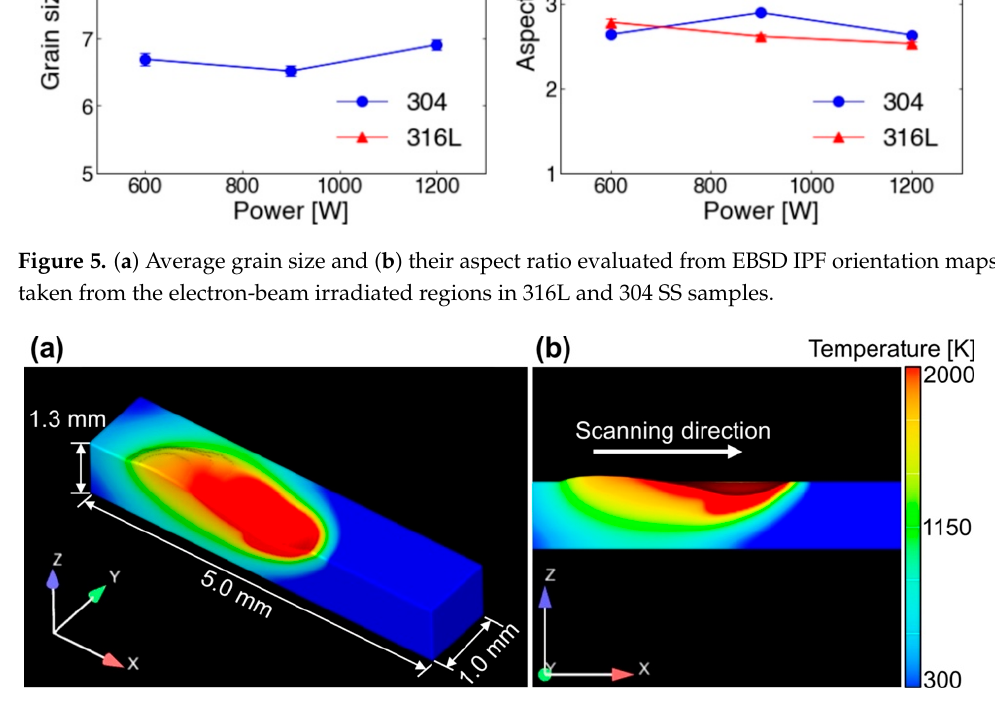
Figure 6. Snapshot of CtFD simulation of electron-beam irradiation on 316L SS with process parame- ters of P = 1200 W and V = 100 mm/s. ( a ) Bird’s eye view, ( b ) side view on the vertical cross section along the center of the scanning line. The color indicates the temperature.